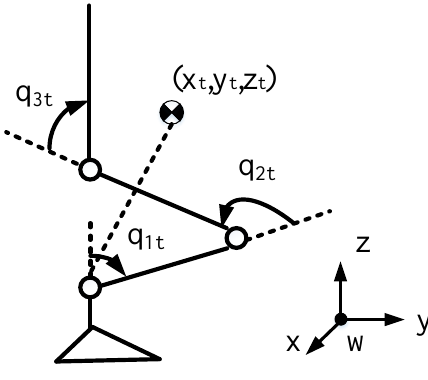
Figure 2. The joint constraint for appropriate reduction ratio